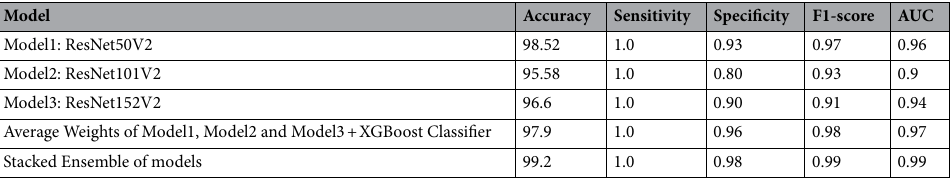
Table 7. Pathology classification results on the INbreast